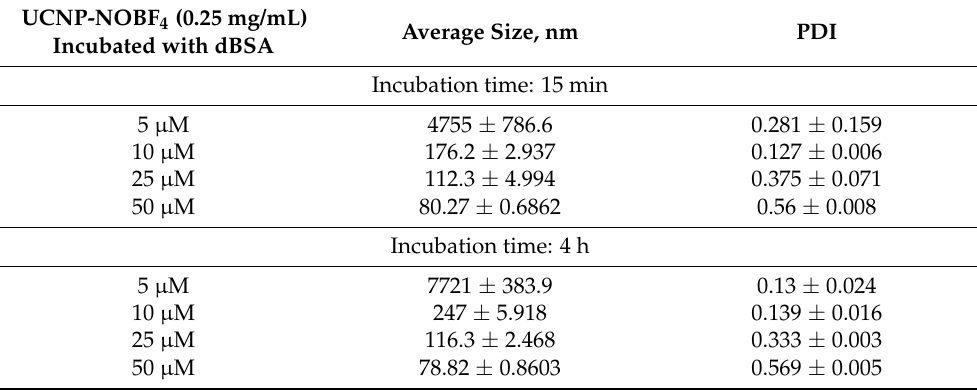
Table 2. The hydrodynamic diameter of dBSA-UCNP-NOBF 4 nanocomplexes at different dBSA concentrations (5–50 µ M) measured by DLS in deionized water.